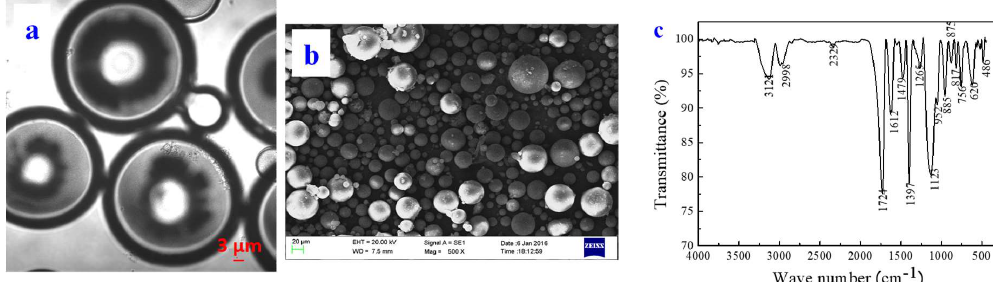
Figure 4. ( a ) The surface morphologies of the dried MIMS examined using FESEM; ( b ) the surface